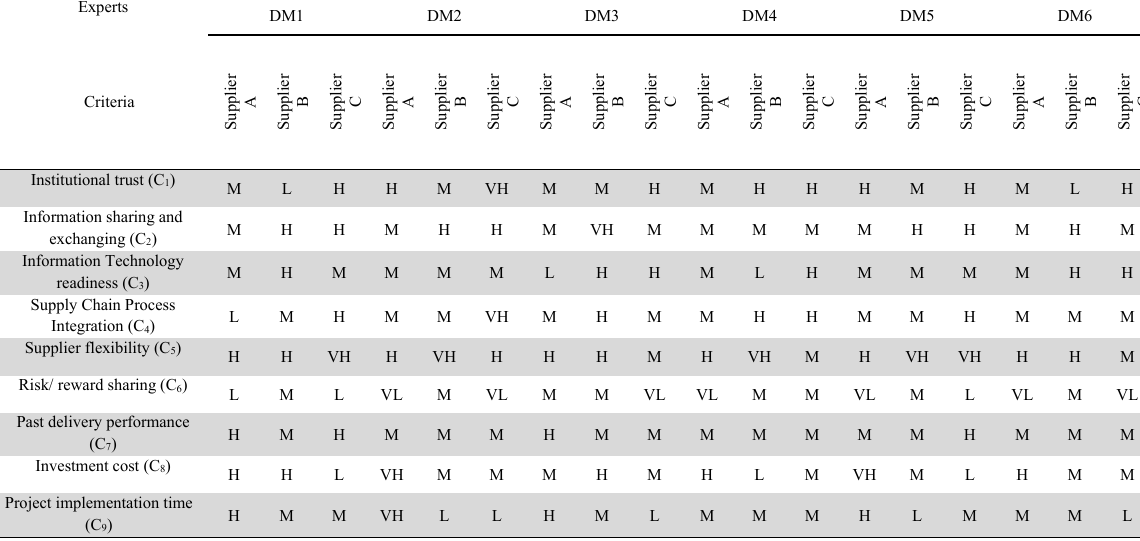
Ratings of decision makers with respect to suppliers and criteria